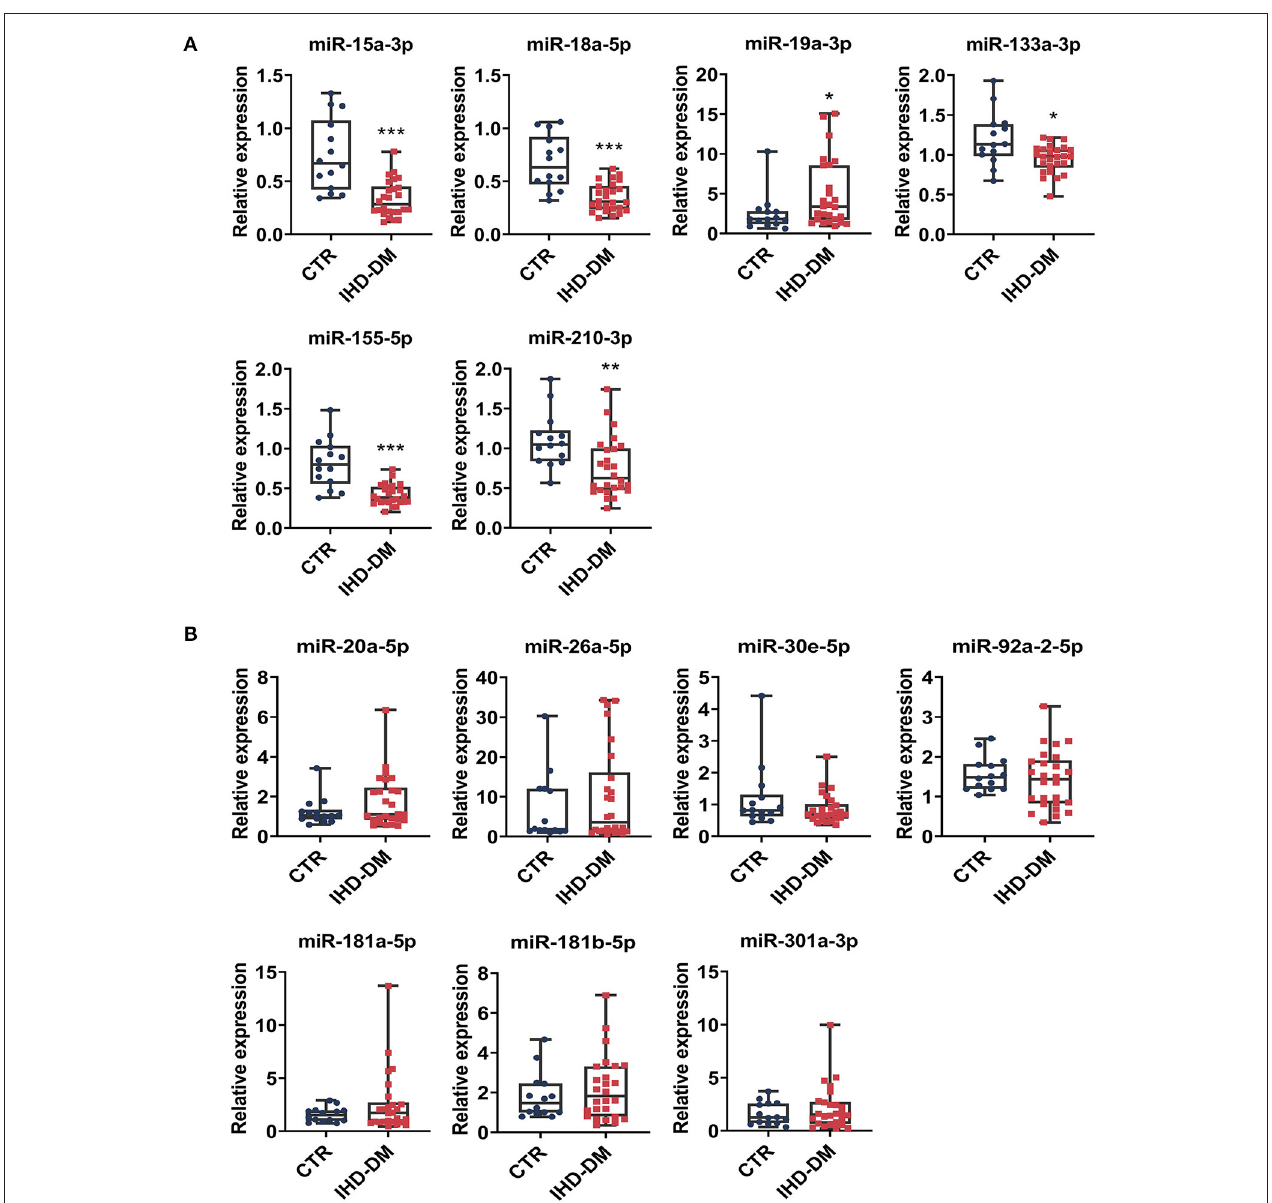
FIGURE 3 | Validation of differentially expressed EV-carried miRNAs between healthy controls and IHD-DM patients. (A) EV-carried miRNAs including miR-15a-3p, miR-18a-5p, miR-19a-3p, miR-133a-3p, miR-155-5p, and miR-210-3p are differentially expressed between the IHD-DM patients and healthy controls. (B) miRNAs such as miR-20a-5p, miR-26a-5p, miR-30e-5p, miR-92a-2-5p, miR-181a-5p, miR-181b-5p, and miR-301a-3p were not statistically significant between the two groups. * P < 0.05 , ** P < 0.01, and *** P < 0.001 indicates significance compared with the control group.